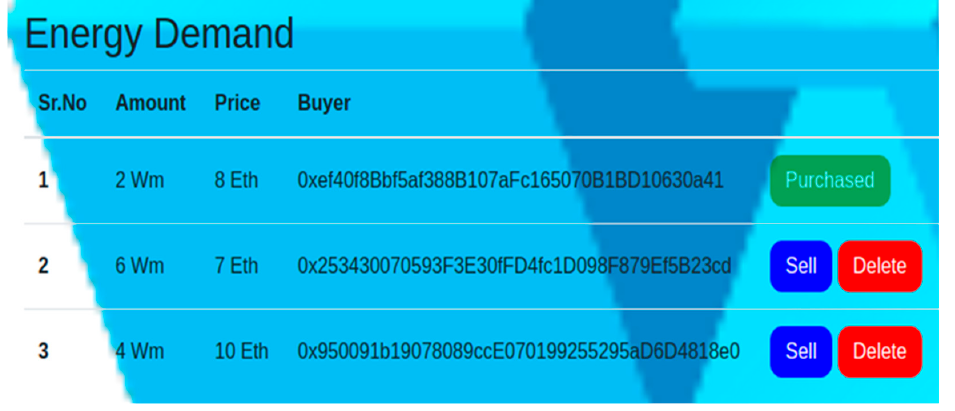
Figure 17. Energy demand on user interface.